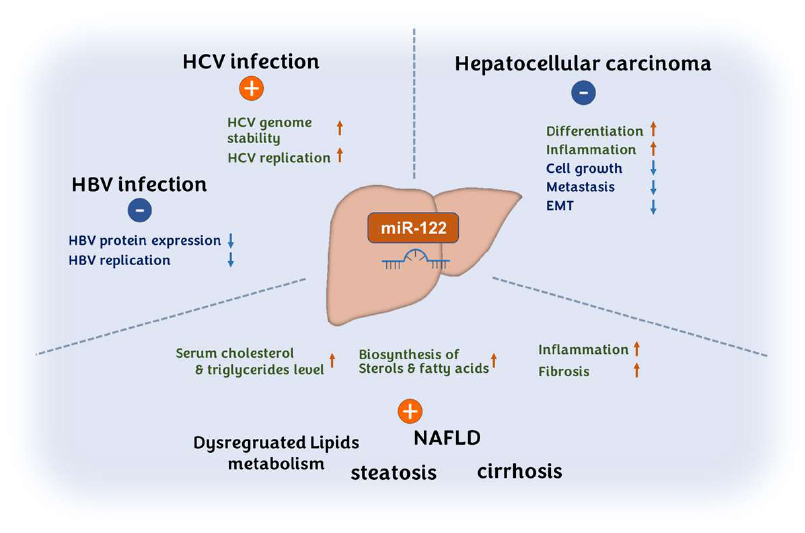
Figure 1. miR-122 is involved in the development of viral infections, hepatocellular carcinoma, and various metabolic conditions. miR-122 negatively regulates the pathogenic progress of hepatocellular carcinoma; promotes hepatitis C viral proliferation while suppressing hepatitis B viral proliferation; increases the biosynthesis of sterols and fatty acids; and accelerates the progression of inflammation and fibrosis, leading to lipid-related metabolic disorders.